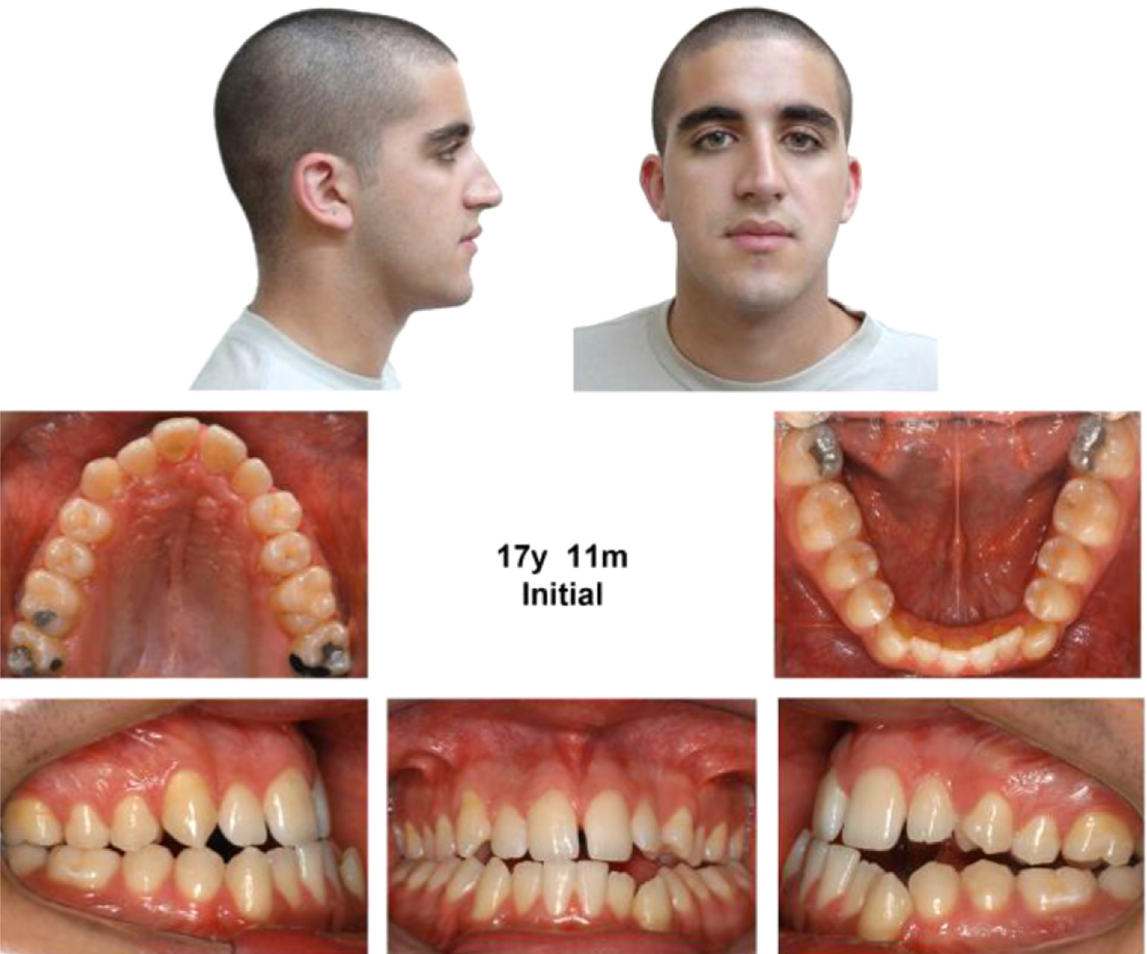
Figure 1. Extra- and intra-oral pretreatment